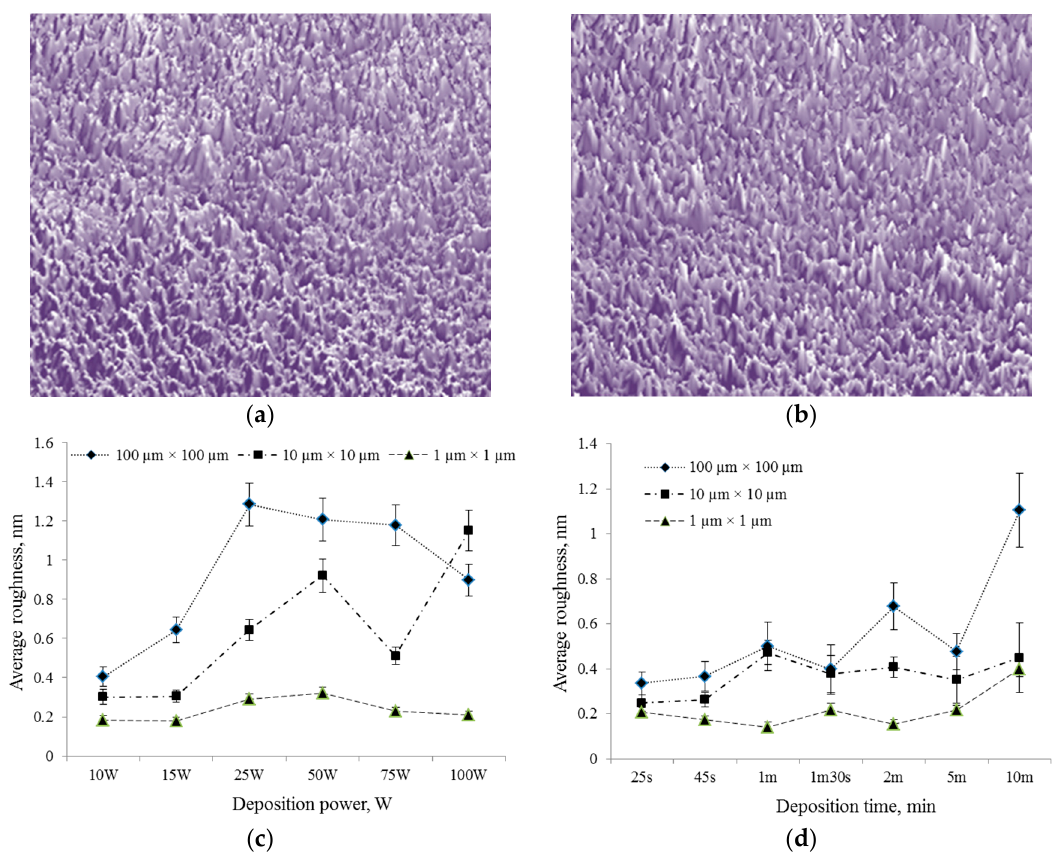
Figure 6. Representative atomic force microscope (AFM) images of ( a ) pristine and ( b ) iodine-doped polyterpenol thin films deposited on glass substrates. Evolution of average surface roughness of iodine-doped films as a functions of ( c ) deposition power when deposition time is fixed at 10 min, and ( d ) as a function of deposition time when deposition power is fixed at 25 W.